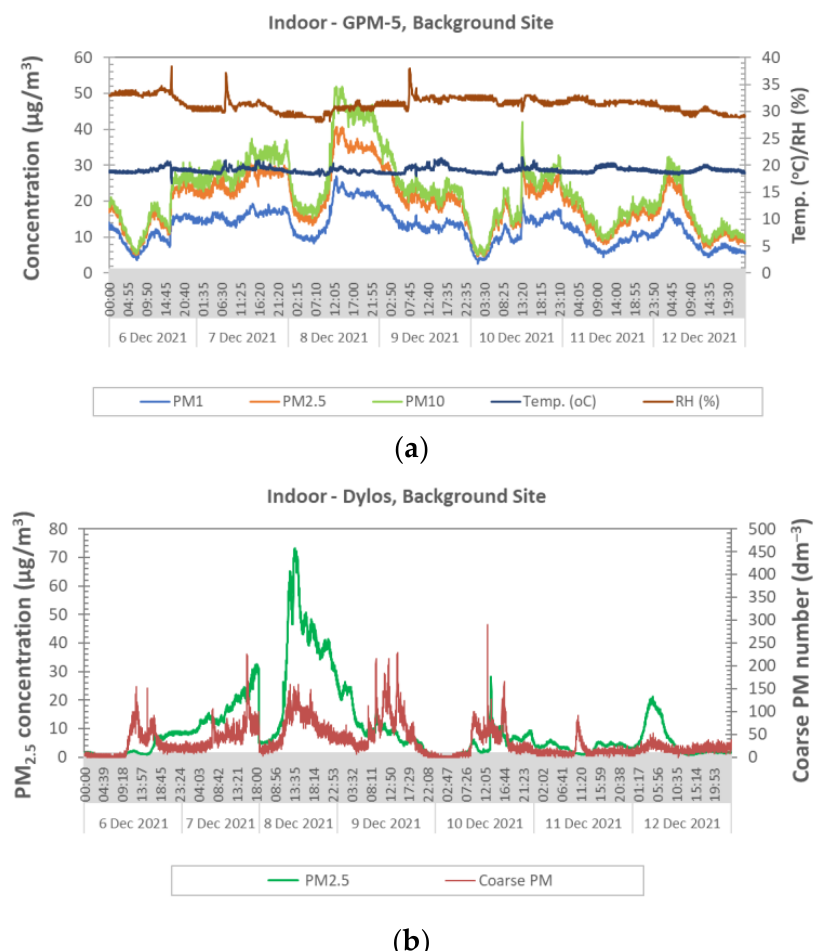
Figure 16. Temporal PM and microclimatic data for GPM ( a ) and Dylos ( b ) monitors at the back- ground site, indoors (office room) between 6 and 12 December 2021 (sampling rate: 1–5 min, n = 2003).